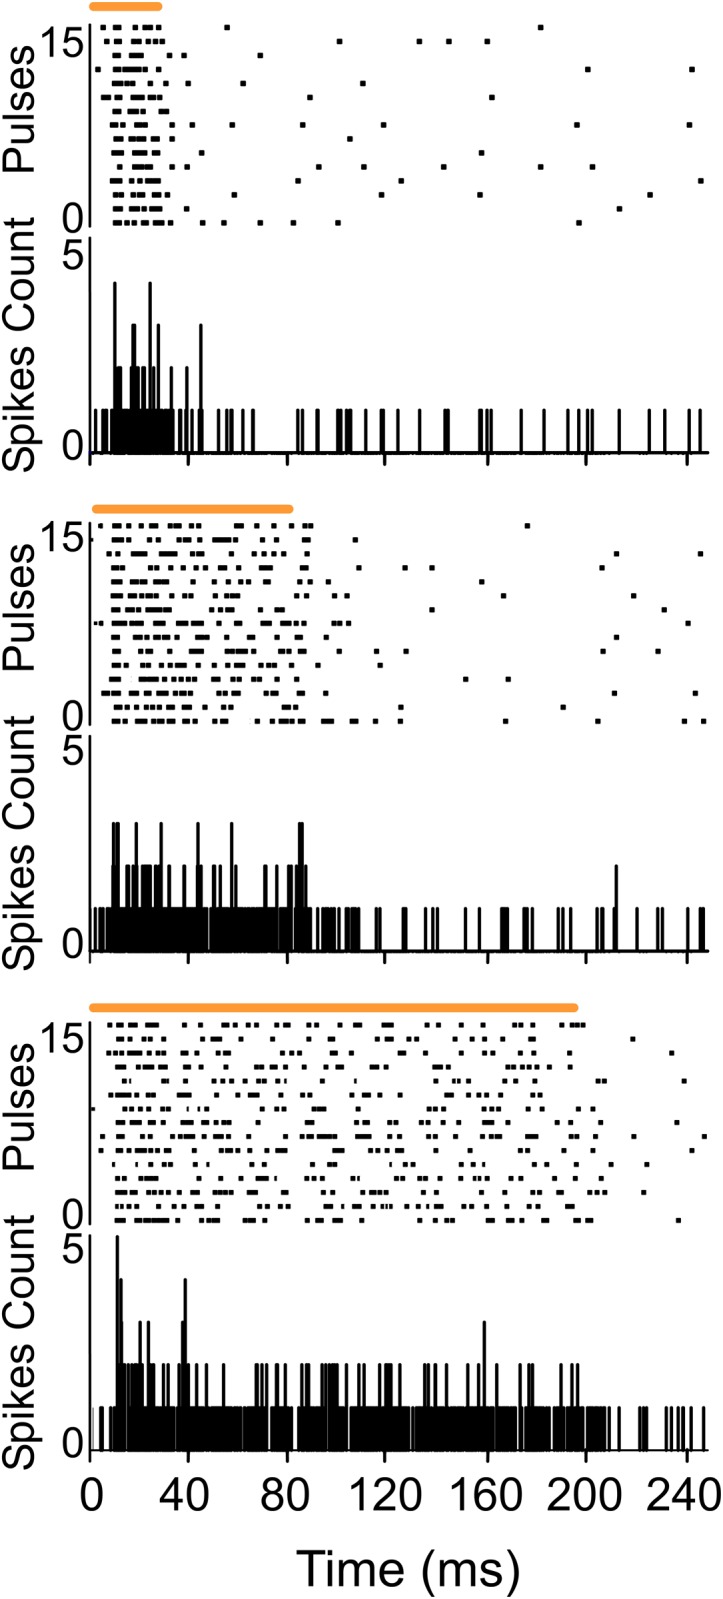
POm responses lasted the duration of the whisker stimulus.Raster plots and PSTHs showing sustained multiunit POm responses evoked by different stimulus duration (top: 20 ms, middle: 80 ms and bottom: 200 ms). Air puff duration is indicated by horizontal orange lines.